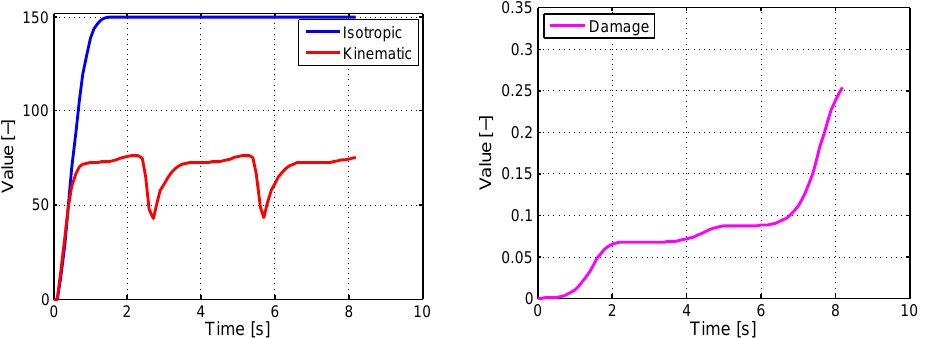
Figure 8. Isotropic and kinematic hardenings- and local damage